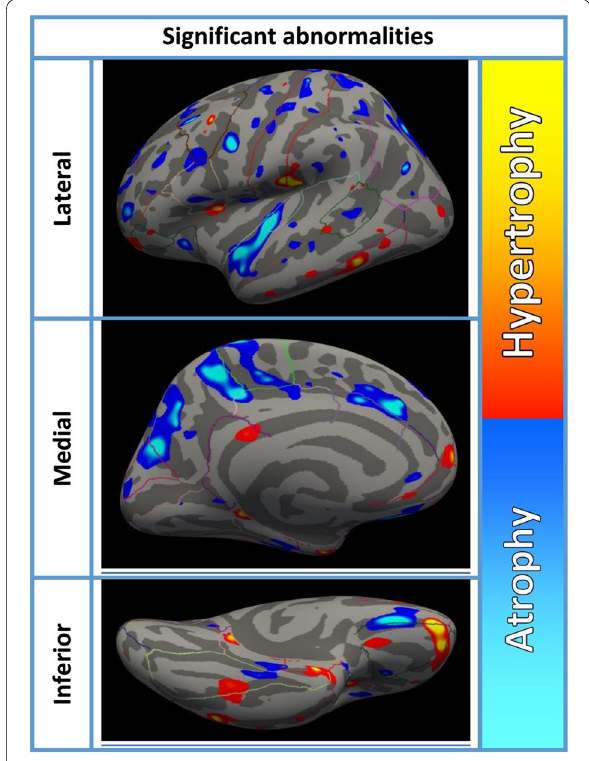
Fig. 6 Morpho-volumetric analysis through Free-surfer software showing abnormalities of left cortical thickness in a patient with